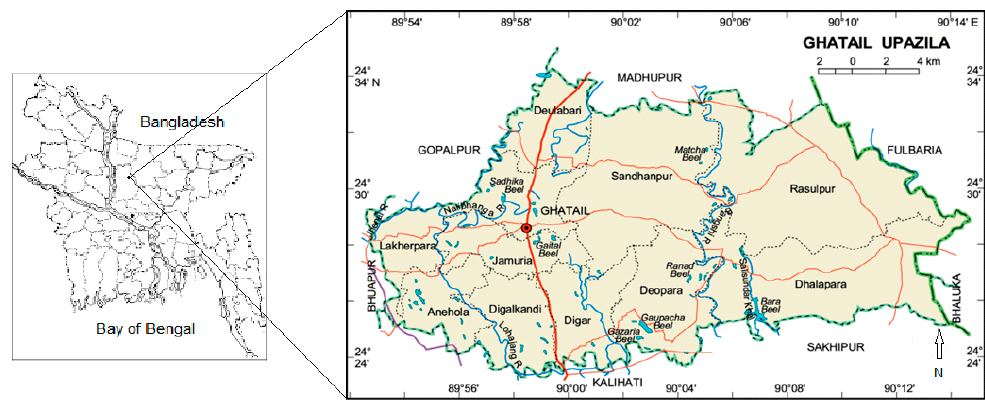
Figure 4. Map of the study location [22].